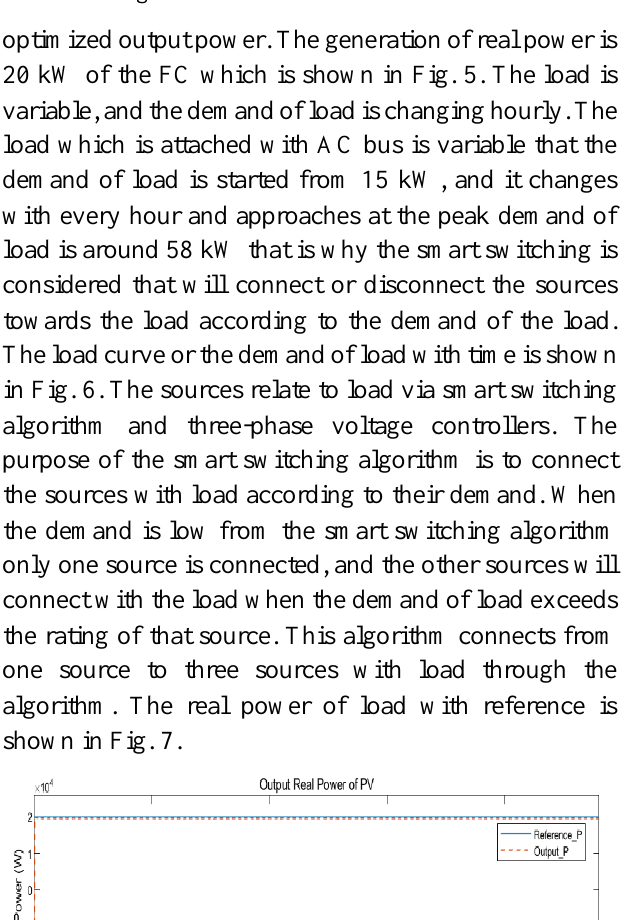
Fig. 2. Proposed layout of smart micro-grid